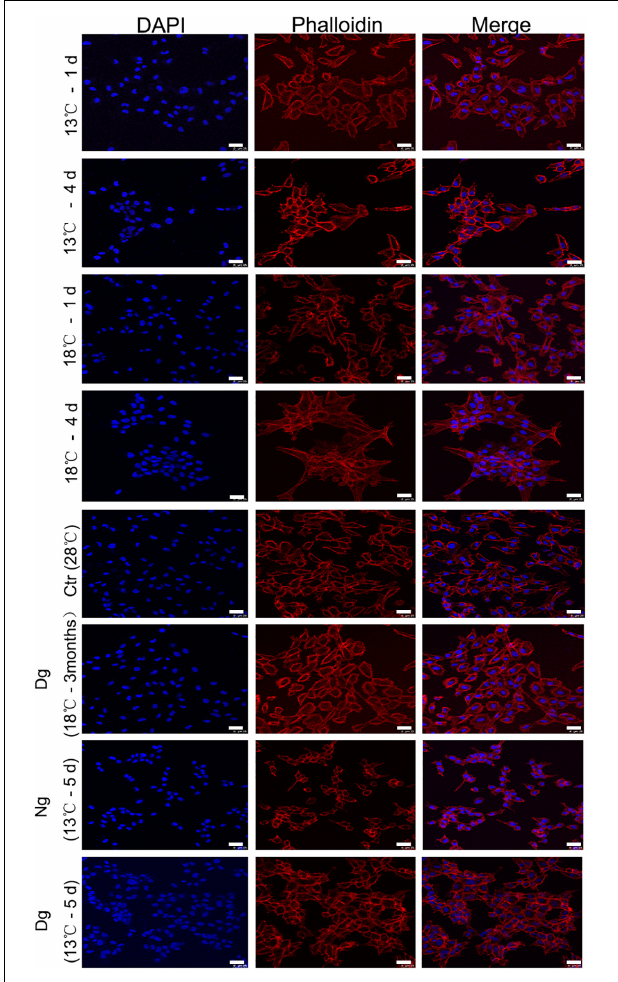
FIGURE 2 | Low temperature acclimation helps to maintain the ZF4 cell cytoskeleton. F-actin was labeled with rhodamin-phalloidin following exposure to low temperatures at different time points in ZF4 cells. The cell cytoskeletons were stained with phalloidin (red) and the staining of nuclei was performed with DAPI (blue). Laser scanning confocal microscopy was used to visualize the cytoskeleton of the cell. Scale bar = 25 µ m. Ctr, the control group; Dg, the domesticated group; Ng, the non-domesticated